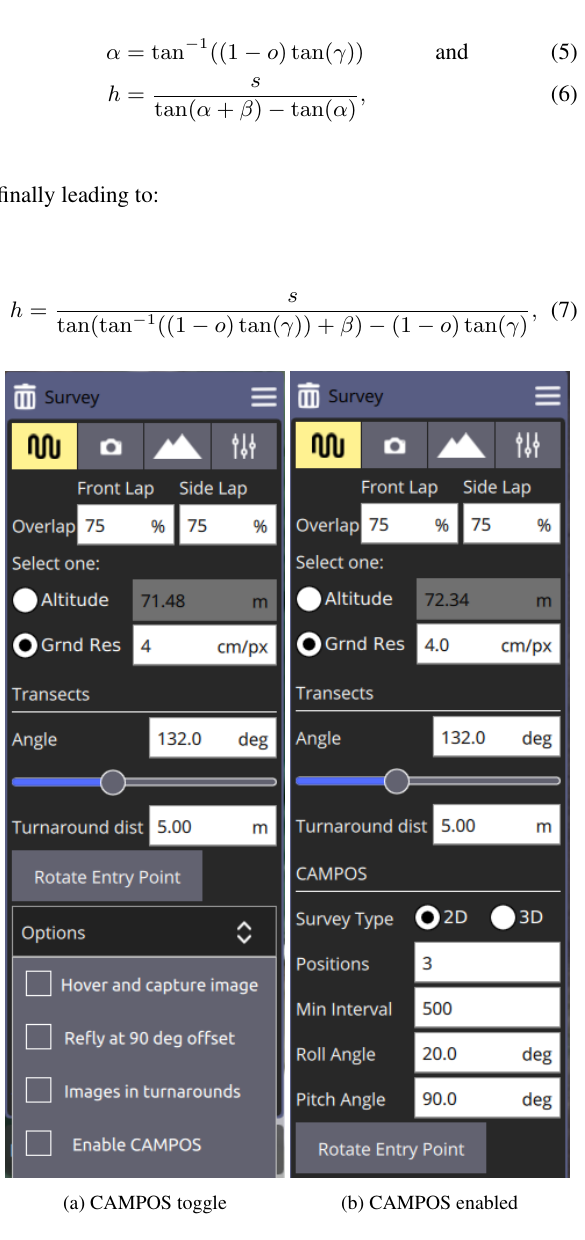
Figure 4. CAMPOS user interface in